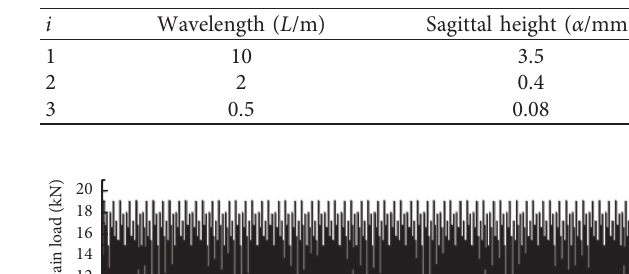
Table 2: Typical irregular vibration wavelengths and corre- sponding vector heights.